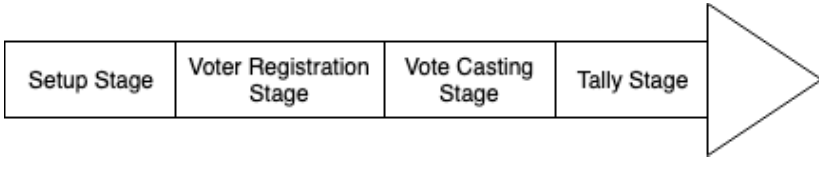
Fig. 1. Stages in the voting